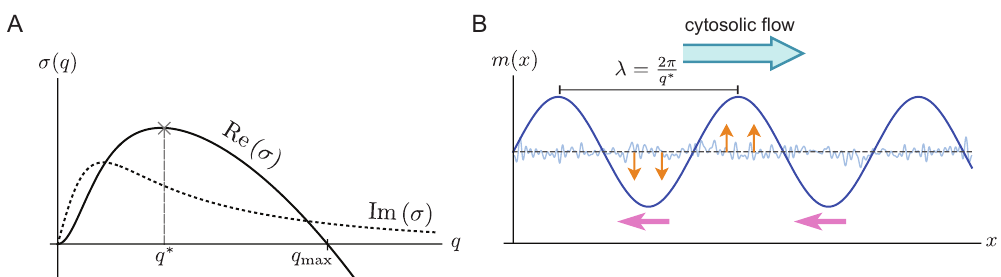
Figure 2. ( A ) Sketch of real (solid) and imaginary (dotted) part of a typical dispersion relation with a band [ 0, q max ] of unstable modes. ( B ) The initial dynamics of a spatially homogeneous state with a small random perturbation (blue thin line). The direction of cytosolic flow is indicated by a blue arrow. The typical wavelength ( λ ) of the initial pattern is determined by the fastest growing mode q ∗ and the phase velocity is determined by the value of the imaginary part of dispersion relation at the fastest growing mode ( v phase = − Im σ ( q ∗ ) / q ∗ ). The growth of the pattern is indicated by orange arrows, while the traveling direction is indicated by pink